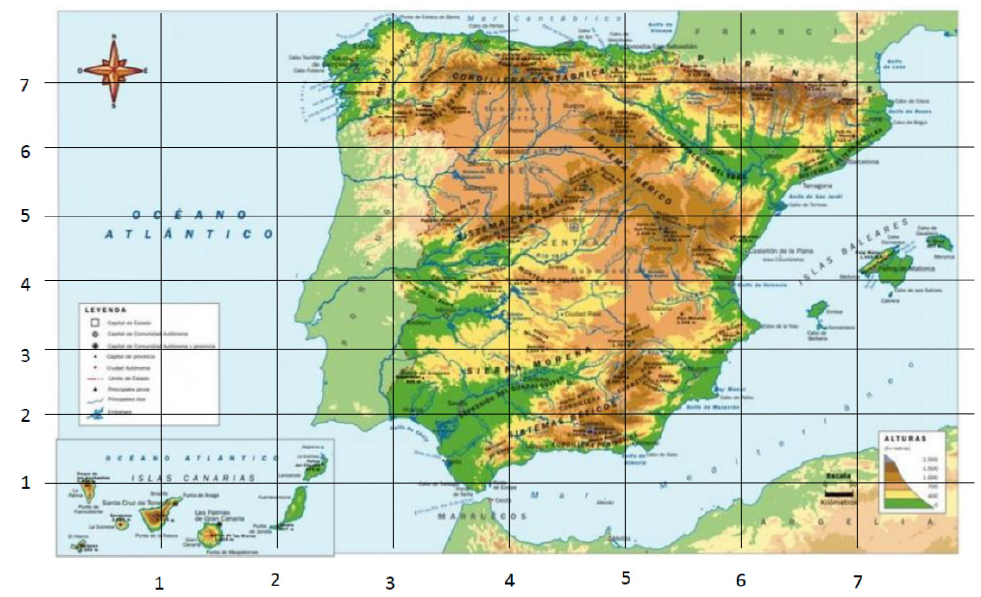
Figure 3. Grid map used in one of the activities.